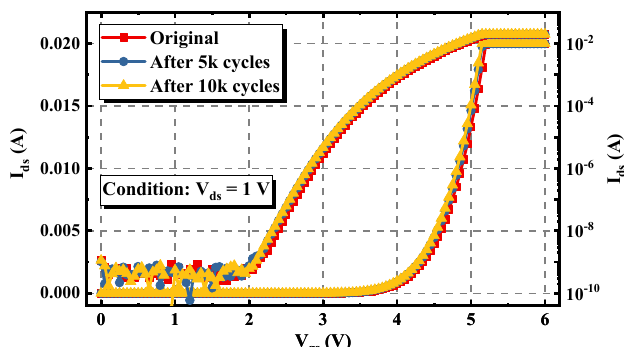
Figure 7. Extracted I d -V g characteristic of the double-trench SiC MOSFET under different avalanche stress cycles.